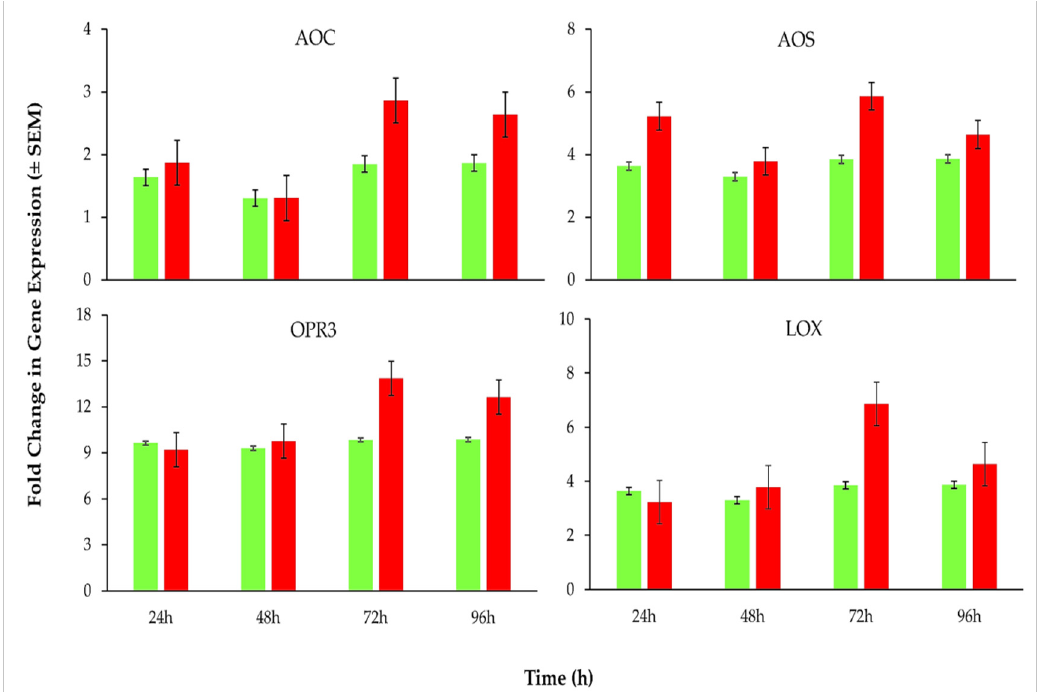
Figure 5. Expression levels of key genes potentially linked to the jasmonic acid (JA)-associated plant defense pathways determined at different post-treatment time intervals (sample size n = 9 for each treatment). Green and red columns represent the results for buffer-treated (control) and protein-treated plants, respectively.